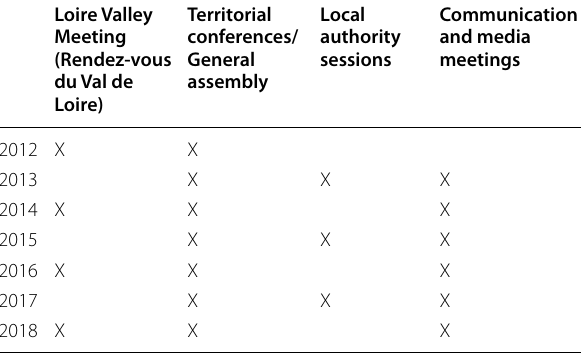
Table 1 Organisation of the four types of meetings for communication and exchanges since 2012